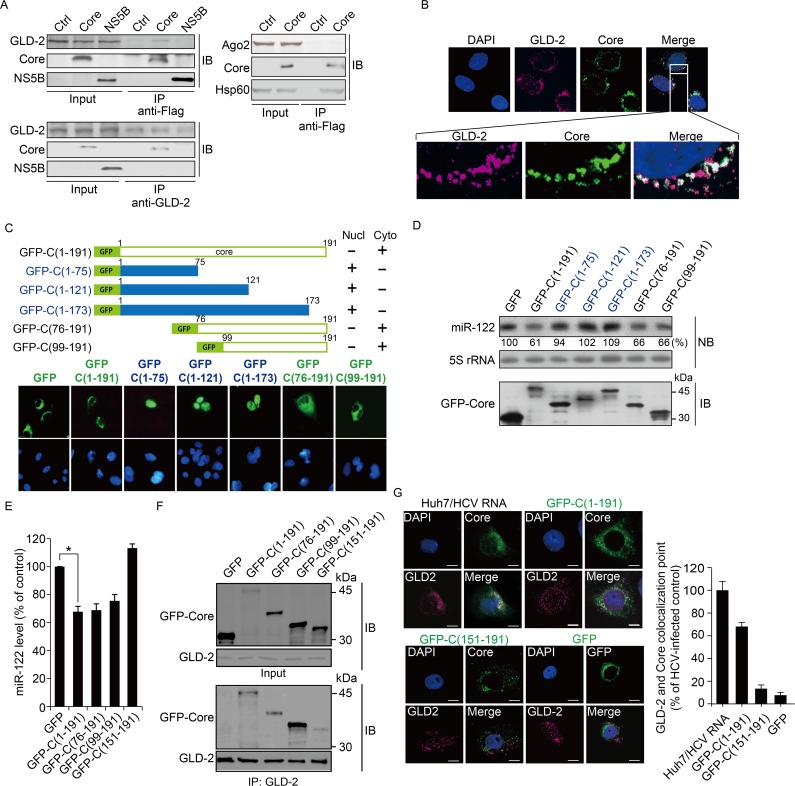
Interaction of the HCV core protein with GLD-2 in the cytoplasm is required for miR-122 expression regulation.(A) Huh7 cells were transfected with an empty vector (Ctrl) or an expression vector encoding Flag-tagged core (Core) or NS5B protein. Lysates were immunoprecipitated with anti-Flag (top) or anti-GLD-2 (bottom) antibody, followed by immunoblotting for the indicated proteins. (B) Indirect double-immunofluorescence staining of the core protein and GLD-2 in Huh7 cells transiently expressing the Flag-tagged core protein. Nuclei were visualized by DAPI staining. (C and D) Subcellular localization of GFP-fused full-length HCV core protein and its truncated derivatives transiently expressed in Huh7 cells for 48 h was analyzed by immunofluorescence microscopy (C). Nucl, nucleus; Cyto, cytoplasm. (D) represents the levels of miR-122 and GFP-fused core proteins measured by northern blot (NB) analysis and immunoblotting (IB). The numbers below the northern blot indicate the miR-122 level compared with the GFP-transfected control, quantified as described in Fig 1C. Total cell lysates resolved by SDS-PAGE were analyzed by immunoblotting using anti-GFP antibody (bottom). (E) RT-PCR quantification of miR-122 levels in Huh7 cells transiently expressing GFP or the indicated GFP-fused core proteins. (F) Analysis of interaction between GLD-2 and the indicated GFP-fused core proteins by co-immunoprecipitation experiments. (G) Quantitative analysis of colocalization between GLD-2 and the indicated GFP-fused core proteins in Huh7 cells. Huh7/HCV RNA, Huh7 cells transfected with HCV (JFH-1) RNA. Scale bar, 10 μm.